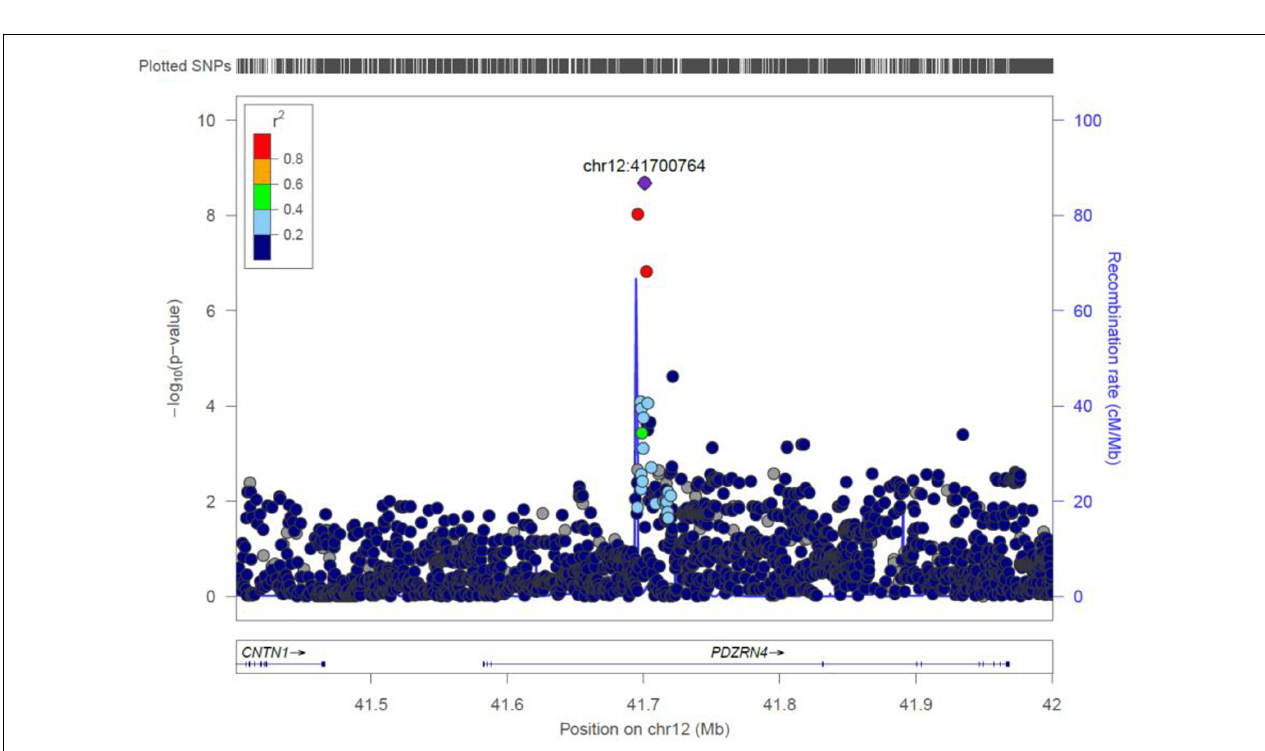
FIGURE 6 | Regional visualization of the GWAS of –log10 of the P -value of genomic location PDZRN4 (rs7296503 in purple), with each dot representing a SNP on the corresponding genes at the bottom.